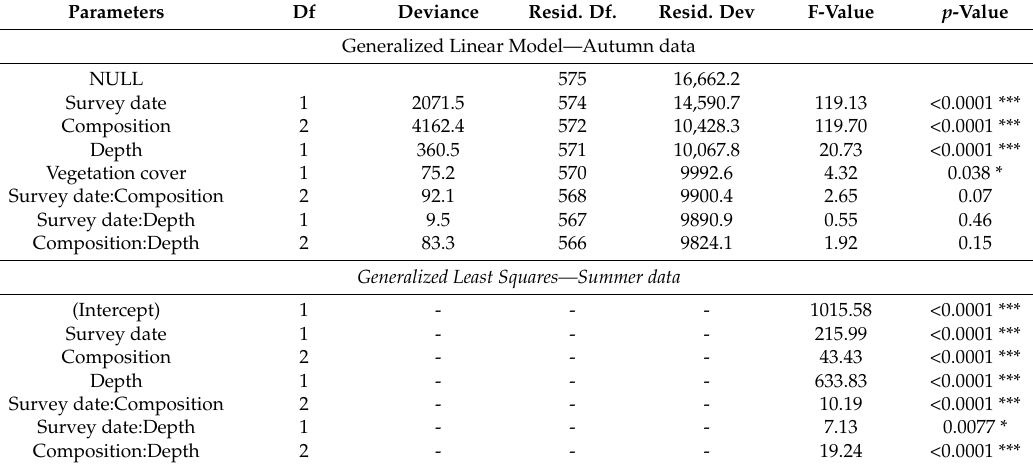
Table 3. Deviance table (Generalized Linear Model (GLM) simple effects and Generalized Least Squares (GLS)) for the response status of soil moisture. Resid.DF are the residual degrees of freedom and Resid.dev is the residual deviance. Significance of the terms is given by the p -values (Signif. codes: <0.0001 ‘***’; <0.001 ‘**’; < 0.05 ‘*’) of the chi-square